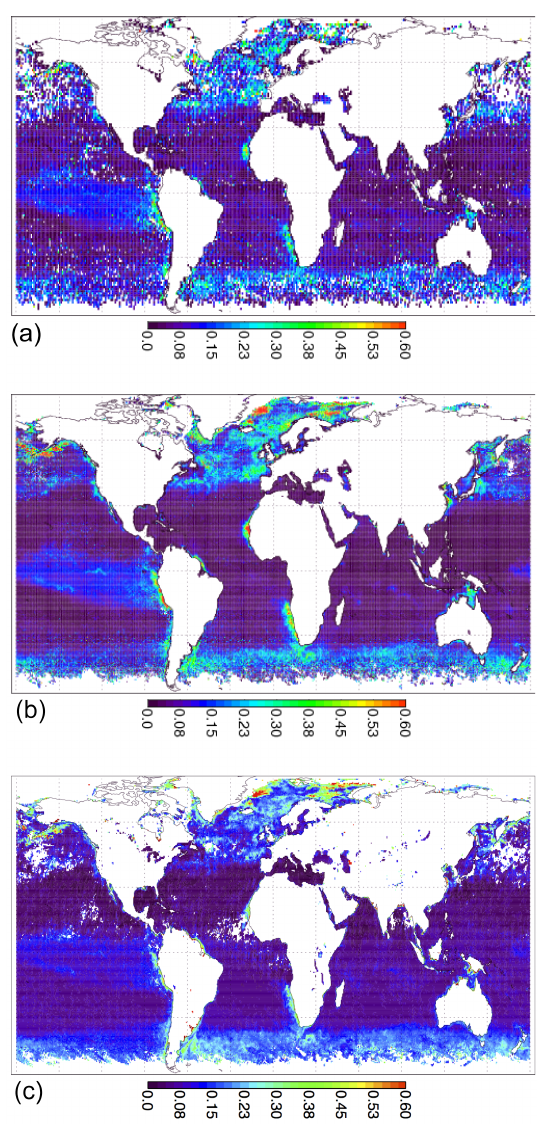
Figure 14. Monthly mean (simplified) normalized fluorescence line height (nFLH) from SCIAMACHY (top), GOME-2 (middle), and Terra MODIS (bottom) in mW/m 2 /sr/nm for May 2007. SCIA- MACHY and GOME-2 are gridded to spatial resolutions of 0.5 and 1 ◦ , respectively. MODIS data were obtained at a 9km spa- tial resolution but regridded to the same resolution as GOME- 2/SCIAMACHY. No zero-level adjustments are made to the re- trievals. (a) SCIAMACHY simplified nFLH as described in text. (b) Similar to (a) but for GOME-2. (c) MODIS nFLH.